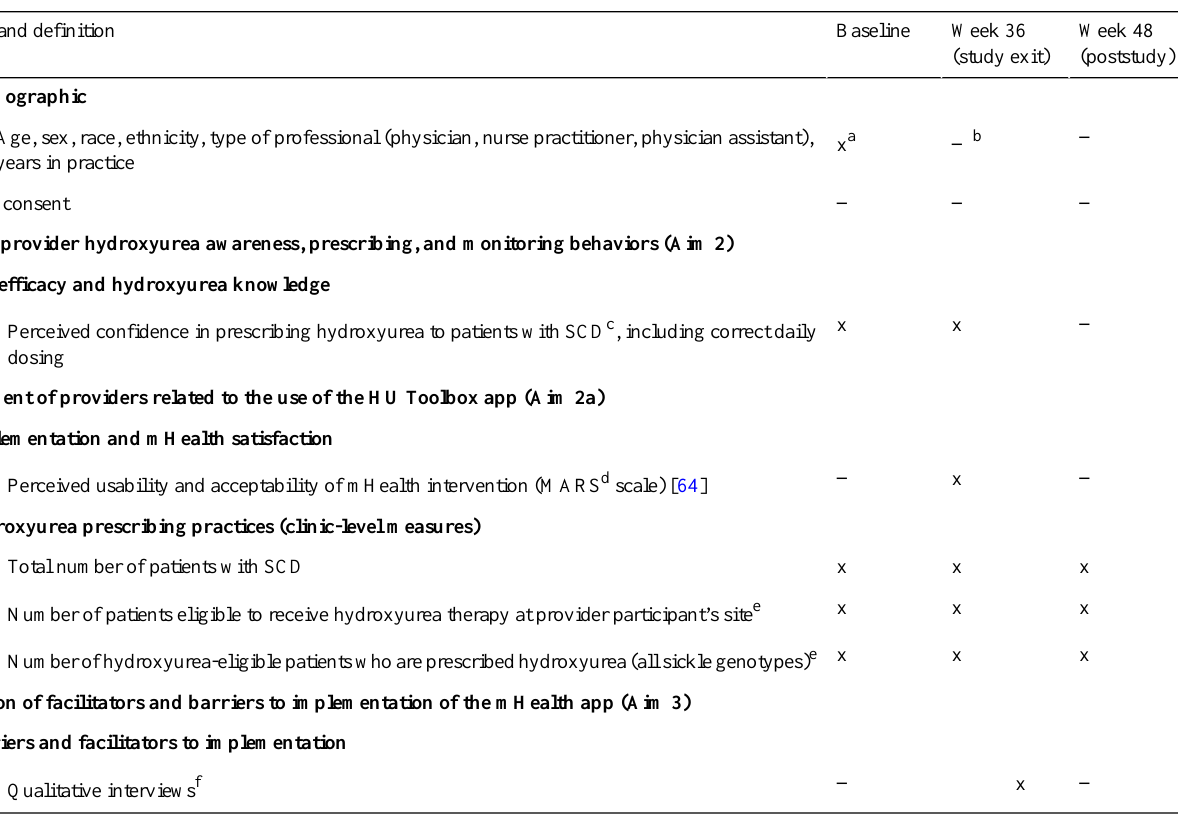
Table 2. Schedule of evaluations for provider